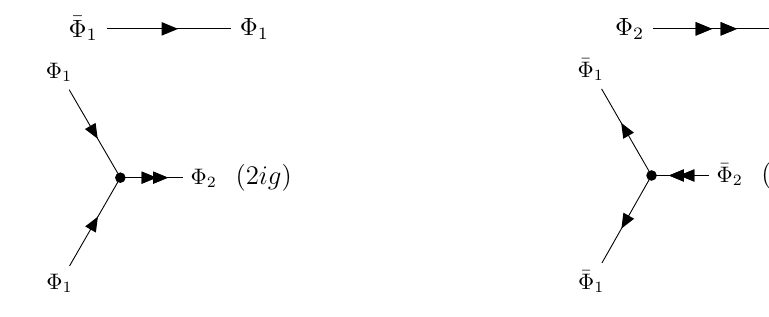
Figure 1. Propagators and vertices in